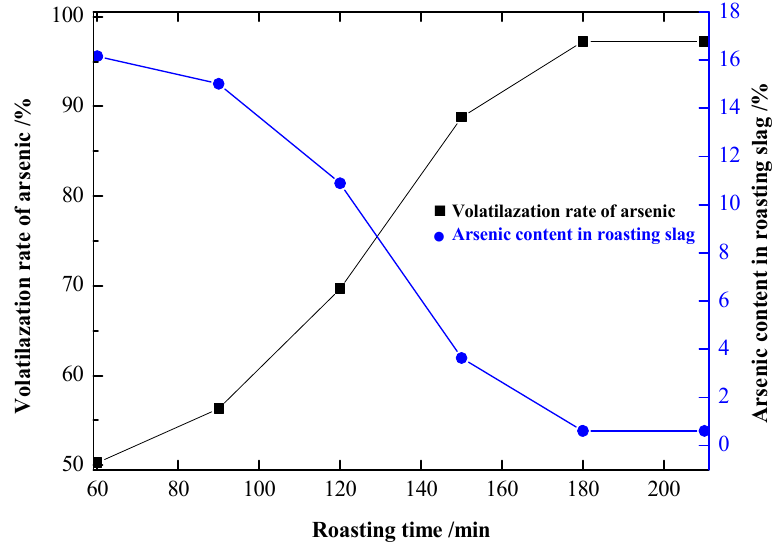
Figure 9. Influence of the roasting time on the experimental results.